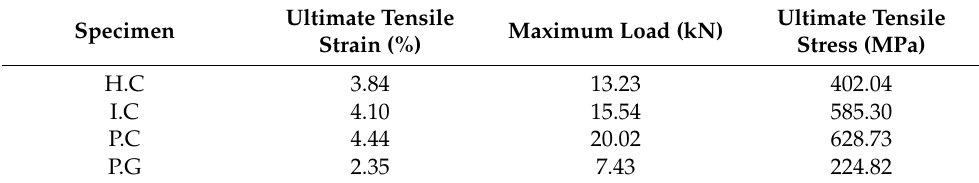
Figure 7. Load-Extension for CFRP/GFRP grid specimen. Table 4. Tensile properties of CFRP/GFRP grid specimen under pull-out test.